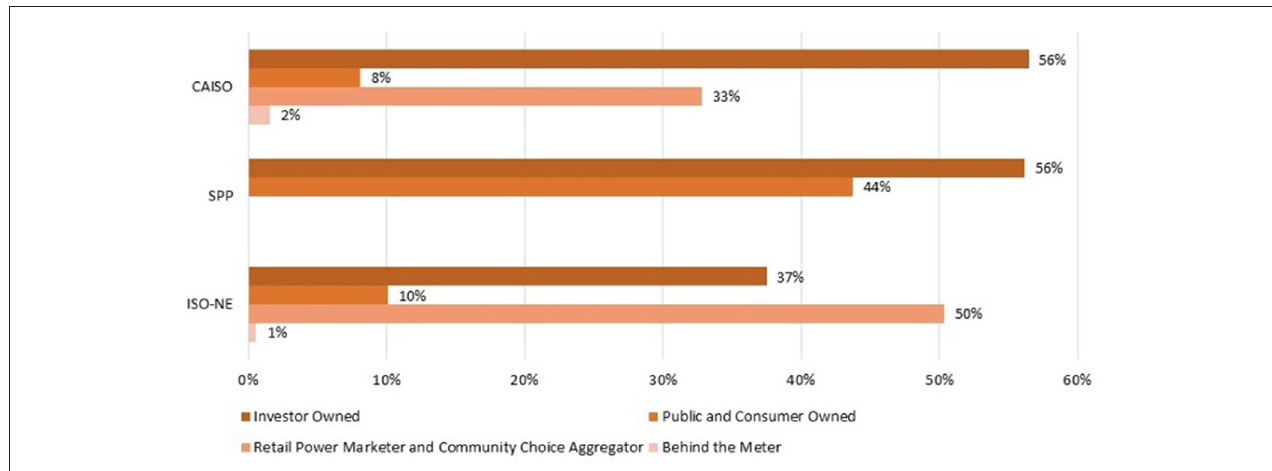
FIGURE 1 | Share of annual megawatthours of sales by ownership type for selected regional transmission organizations. Source: U.S. Energy Information Administration (2020a).